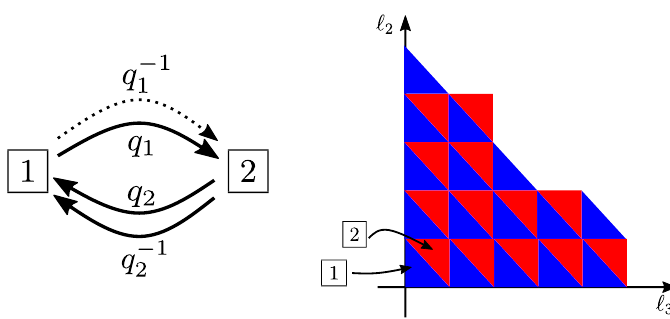
Figure 19. Subquiver and shape of the two-dimensional crystal associated with divisor p 2 = (1 , 0) . It is obtained by removing arrows of the corresponding perfect matching m original quiver diagram. We note α is surrounded by two external legs ‘